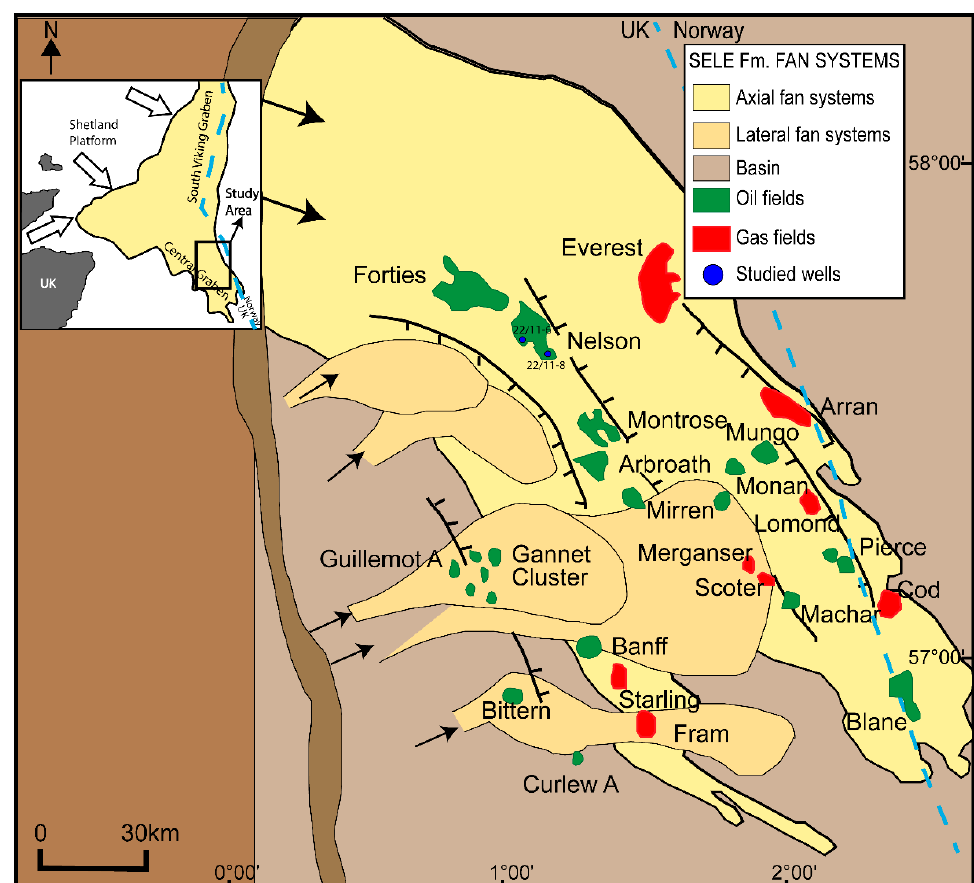
Figure 1. Regional map of the Forties Fan system showing locations of the studied wells in Nelson Field. Modified from [32]). Field. Modified from